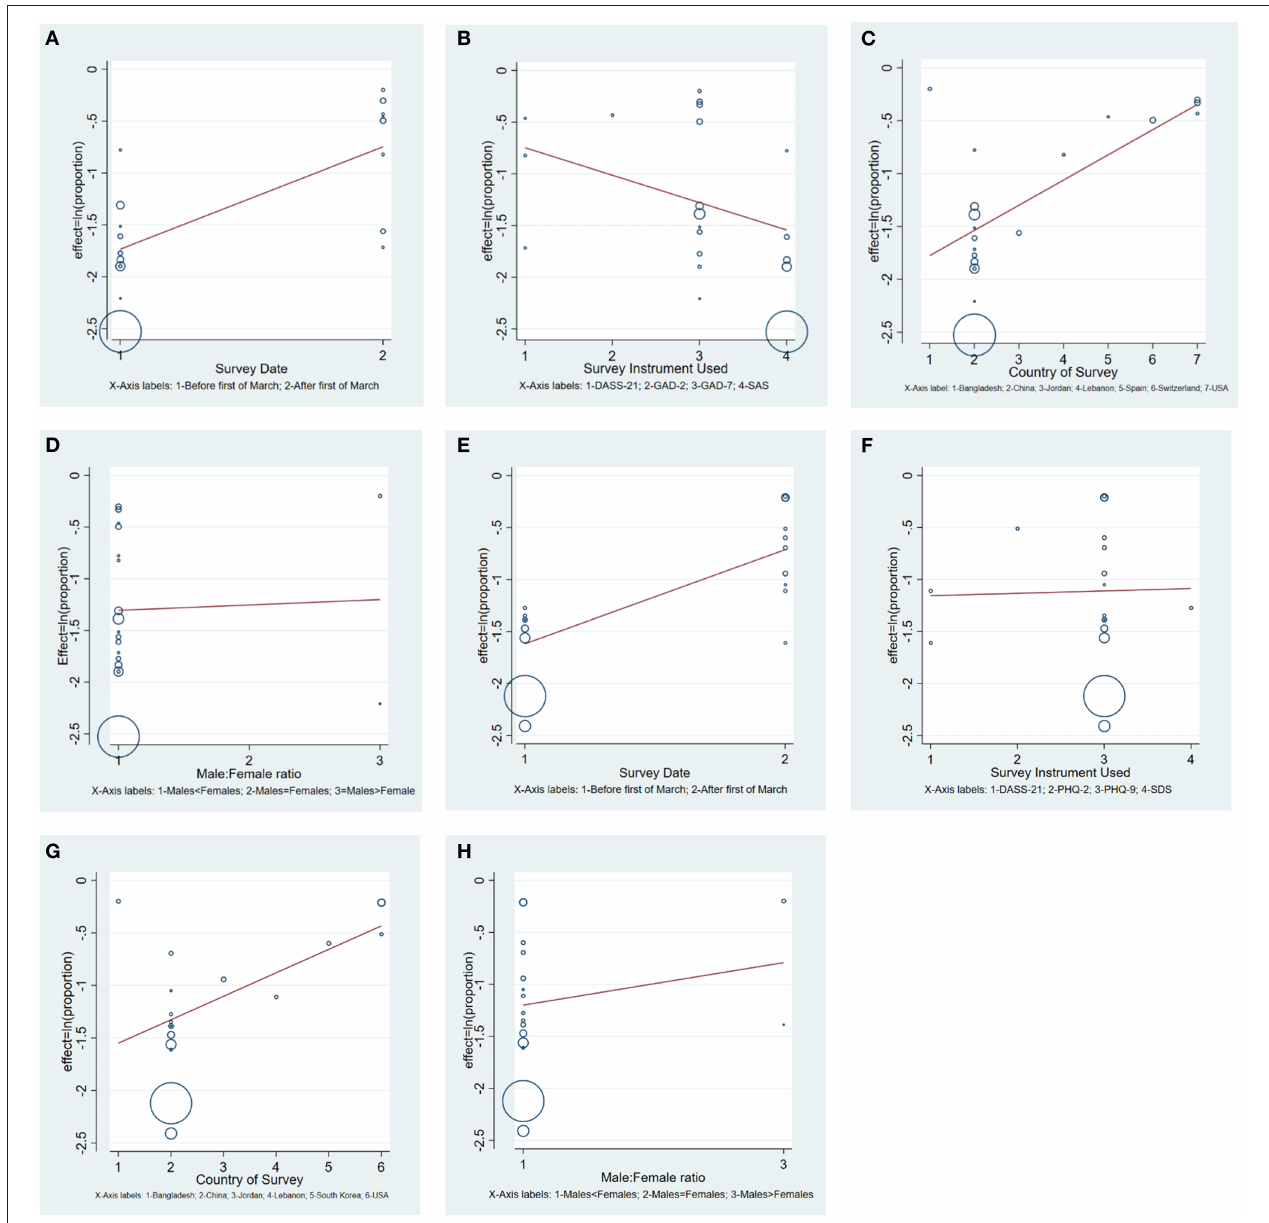
FIGURE 1 | Meta-regression of pooled proportions (proportion = prevalence/100%) of anxiety and depression. (A) Anxiety proportion stratified by survey date; (B) anxiety proportion stratified by survey instrument; (C) anxiety proportion stratified by survey country; (D) anxiety proportion stratified by male-female ratio; (E) depression proportion stratified by survey dates; (F) depression proportion stratified by survey instrument; (G) depression proportion stratified by survey country; and (H) depression proportion stratified by male-female ratio.